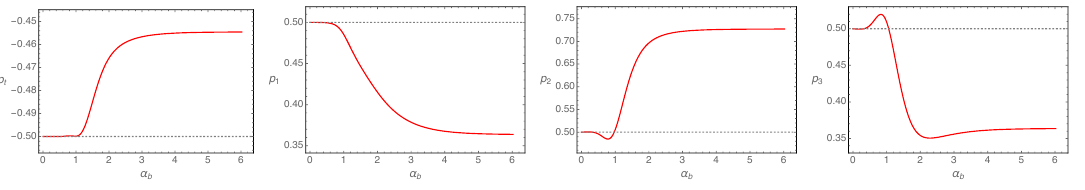
Figure 4 . The Kasner exponents as functions of α b at T/k = 0 . 1 . The gray dotted line is corresponding value of Schwarzschild black